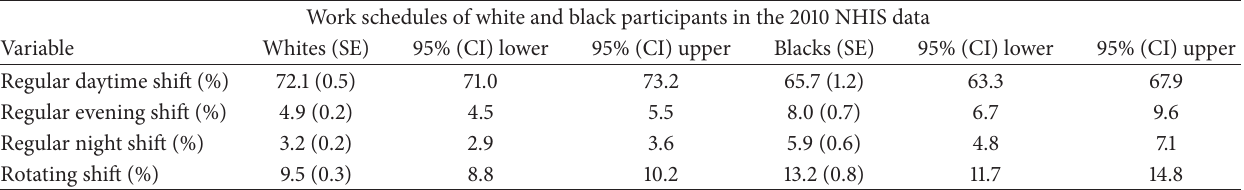
Table 2: Distribution of work schedules among white and black NHIS participants. Work schedules of white and black participants in the 2010 NHIS